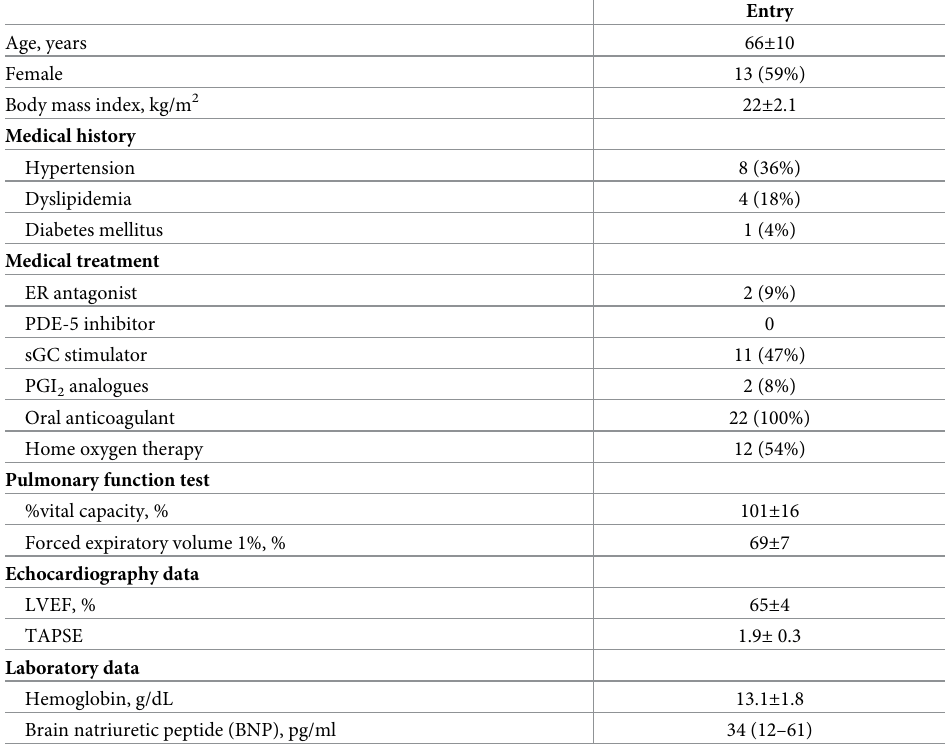
Table 1. Patient